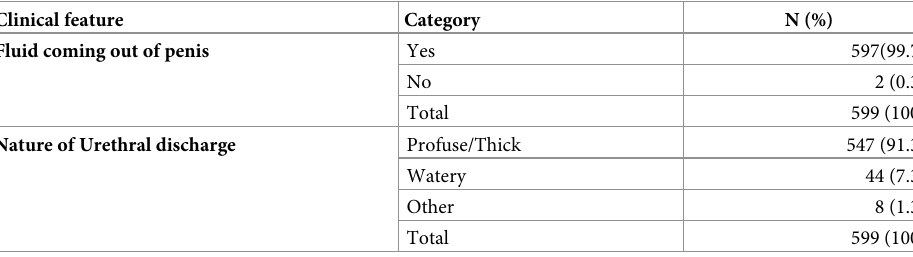
Table 1. Clinical presentations of urethral discharge from patients visiting health centers in Addis Ababa. Clinical